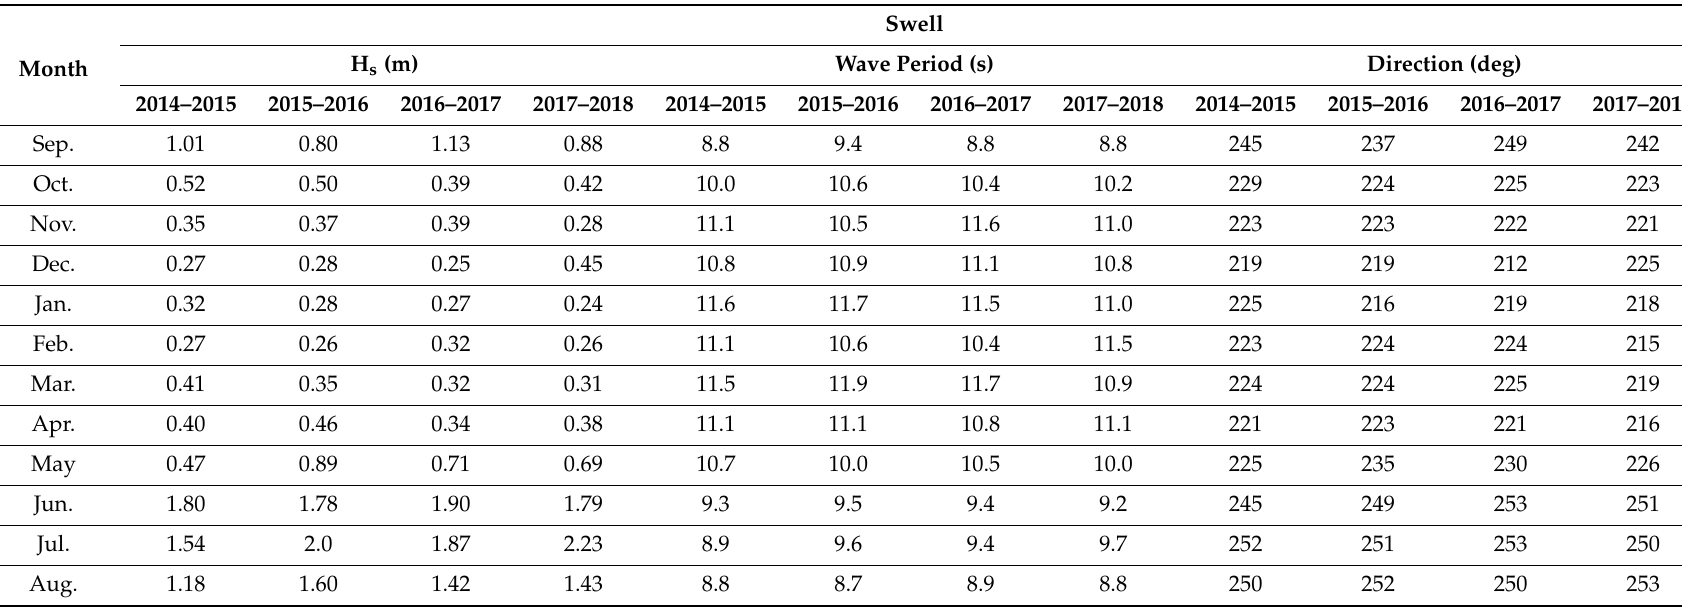
Table 2. Monthly average of significant wave height, mean wave period and mean wave direction of swell measured at 15 m water depth for four